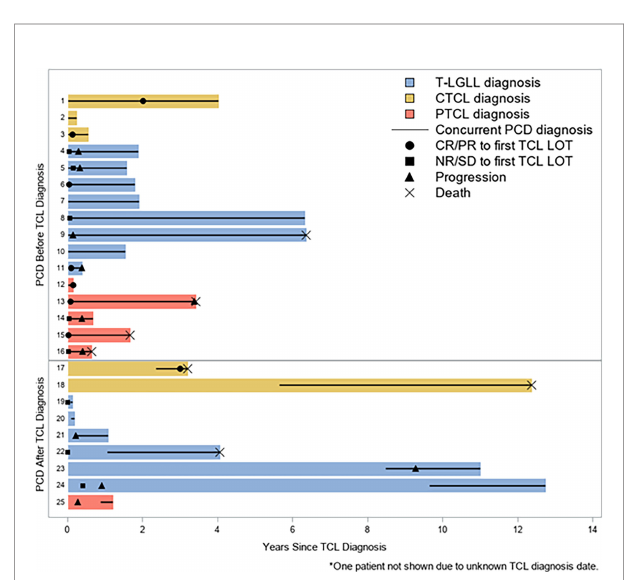
FIGURE 3 | Swimmer's Plot for Entire Cohort. Swimmer's Plot showing all patients in relation of time of diagnosis of T-Cell Lymphoma (TCL). Patients are split by whether they were diagnosed with T-cell Malignancy or PCD fi rst. Lines on the solid color bars represent concurrent diagnosis. Legend describes when patients had progression or